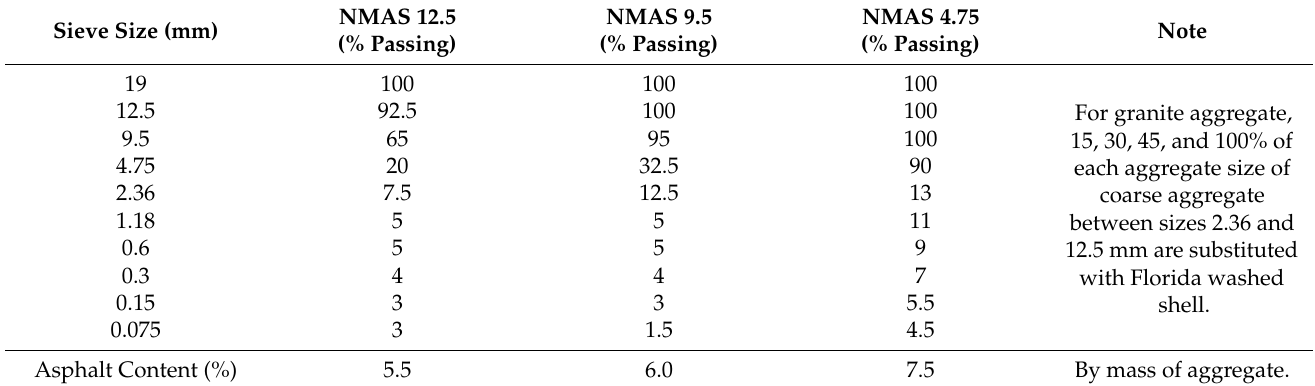
Table 1. Gradation and binder content for different open-graded asphalt